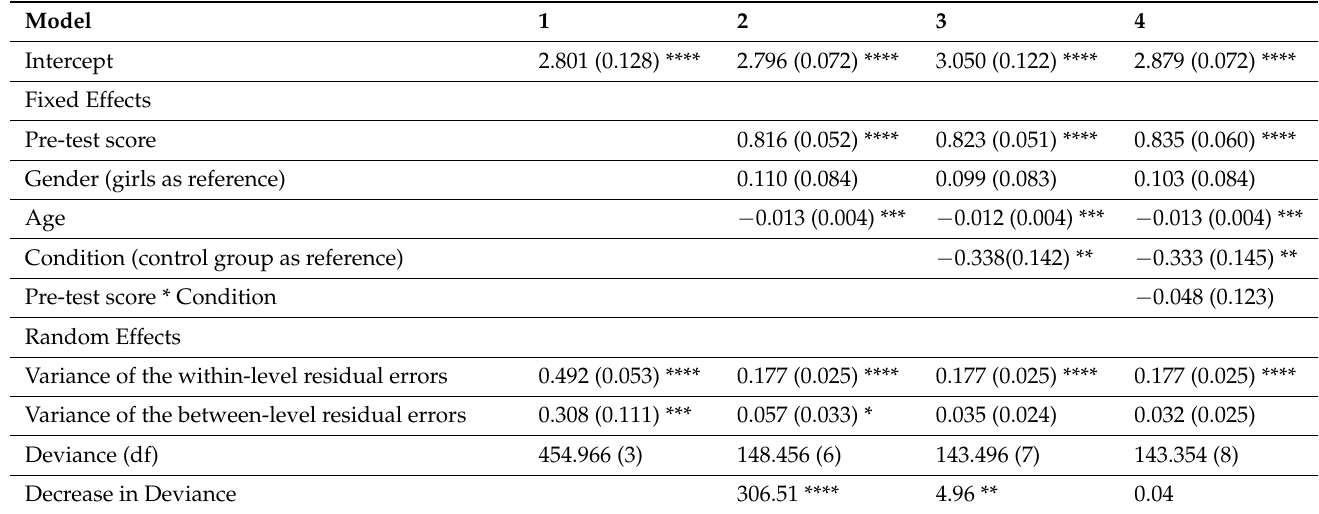
Table 6. Multilevel models explaining the SDQ total difficulties post-test score ( N =